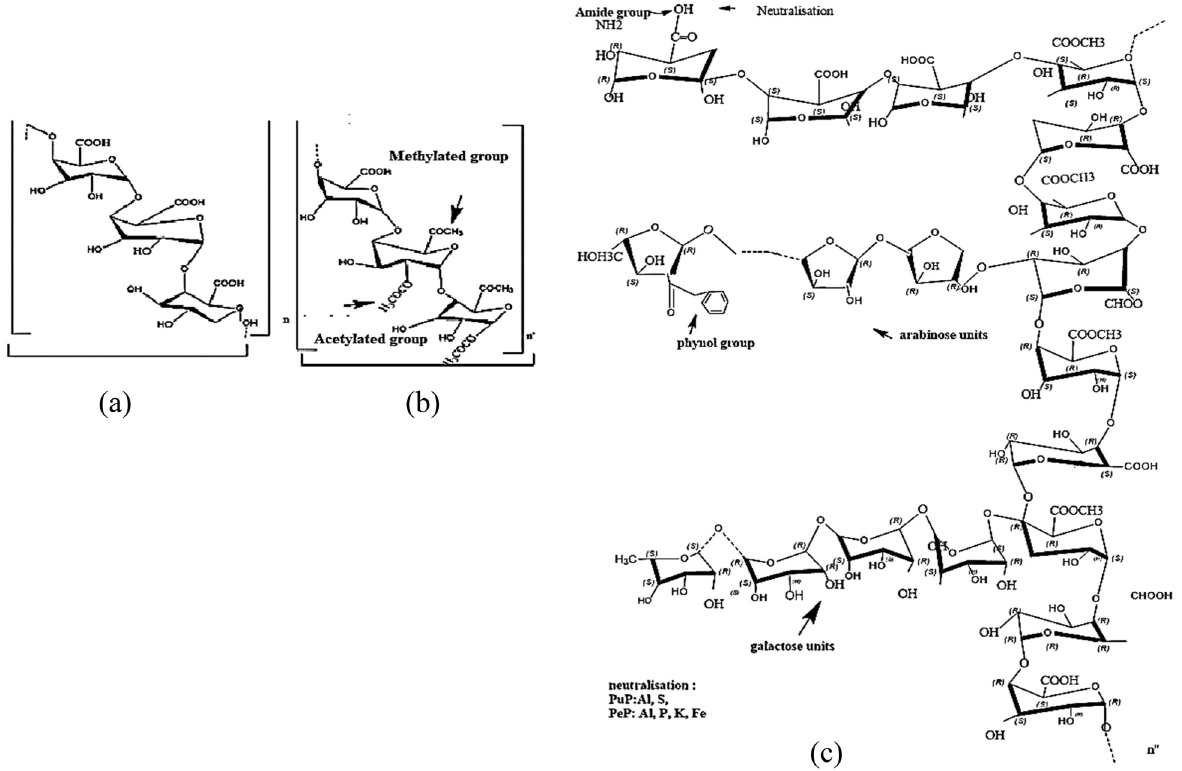
Figure 5: Structural features of pectin isolate from pumpkin pulp and peel: ( a ) HG, ( b ) HG esteri fi ed, and ( c ) RG - I.